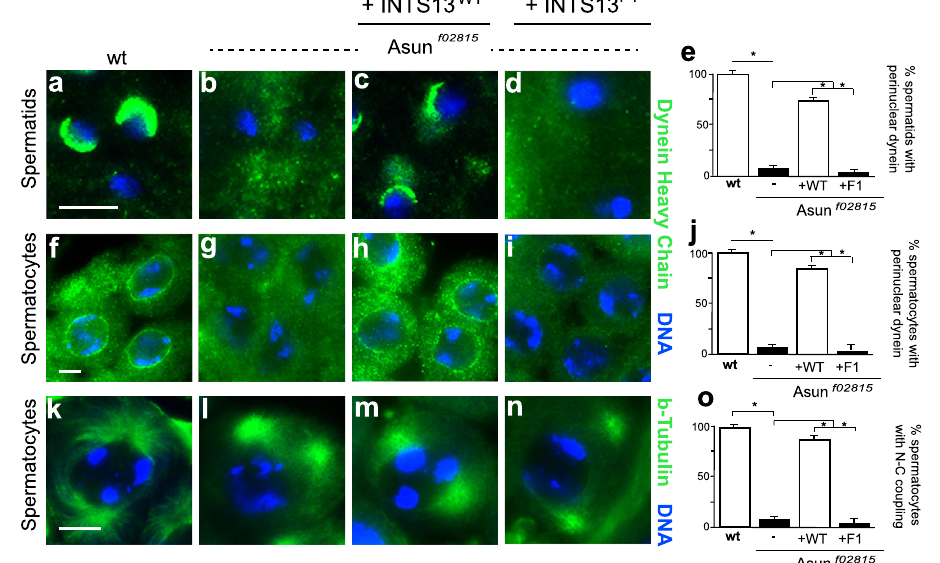
Fig. 6 | Human wild-type INTS13, but not mutant INTS13-F1, rescues sperma- togenesis defects of Drosophila mutant ints13 males. a – j Male germline expression ofwild-type,full-length human INTS13 (INTS13-wt),but nota truncated form (INTS13-F1), restored perinuclear dynein in Drosophila asun primary sper- matids ( a – d ; quanti fi ed in e ) and spermatocytes ( f – i ; quanti fi ed in j ). Representa- tive G2 spermatocytes and immature spermatids stained for dynein heavy chain (green) and DNA (blue) are shown. Bar graphs depict percentages of spermatids and spermatocytes showing properly localized dynein heavy chain. k – o Male germline expression of wild-type, full-length human INTS13, but not INTS13-F1,